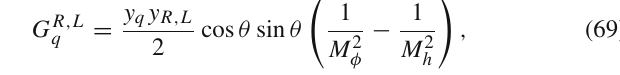
( M ) at the star X pl ˆ h 2 = 1 is not DM